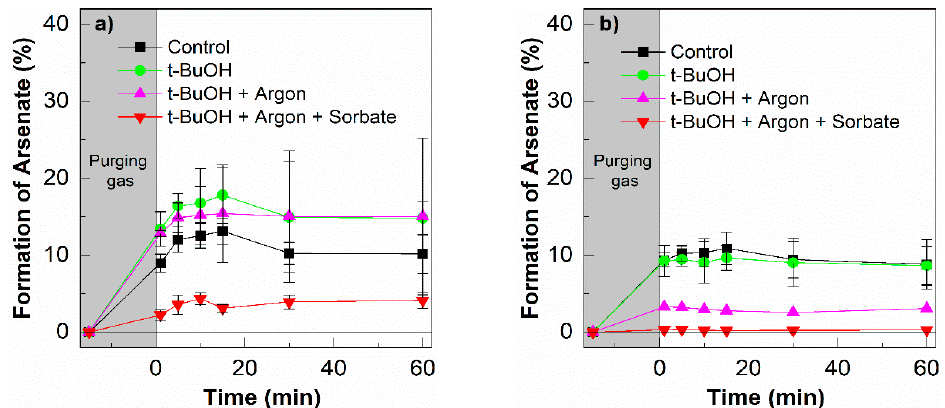
Figure 10. ( a ) Formation of As(V) in the presence and absence of oxygen, or triplet state quencher sorbate during the photo-irradiation with UVA for 60 min. ( b ) without UVA. [As(III)] 0 = 200 µg L − 1 , [HA-MNP] = 0.2 g L − 1 , [ t -BuOH] = 10 mM, and [Sorbate] = 10 mM; error bars represent the standard deviation of triplicate measurements.